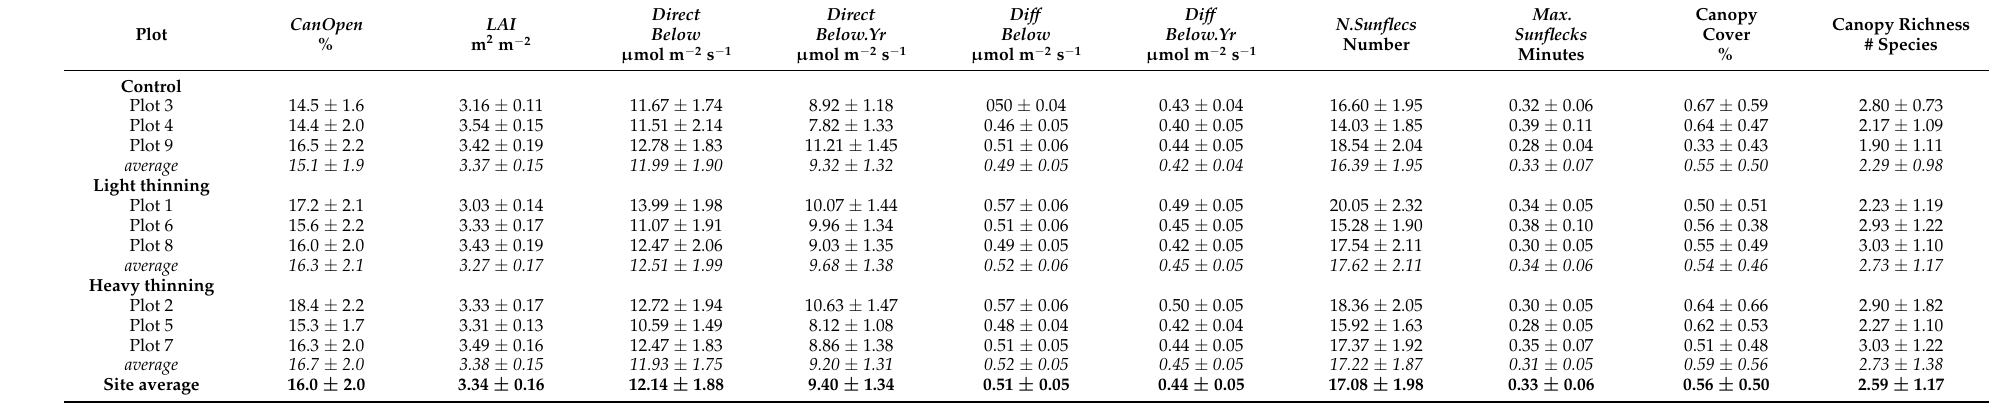
Table 2. Average values of the light-related variables for the monitored period (2005–2019). Values show average ± standard error. Broadleaf subcanopy cover was measured in a 1.0 m radius area surrounding the sampling point and broadleaf subcanopy richness was measured in a 4.0 m radius area.